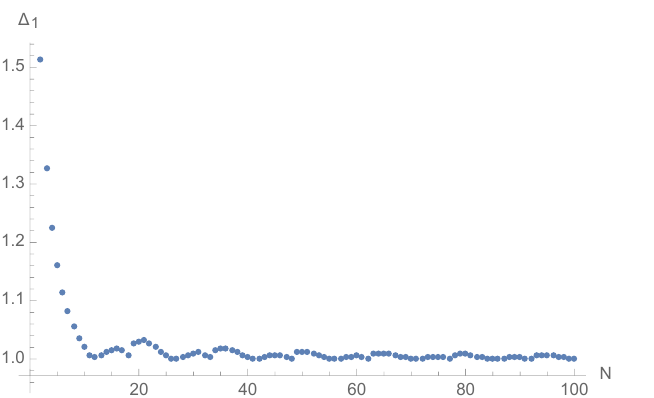
Figure 2 . Plot of scaling dimension of the lightest operator ∆ 1 vs N .